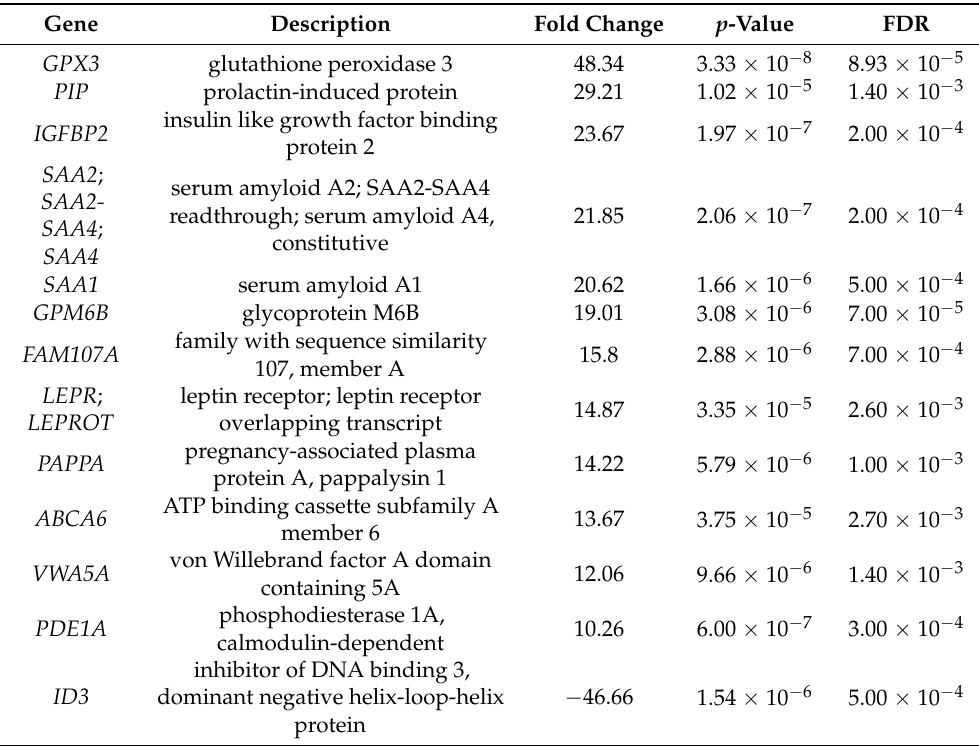
Table 1. Genes that were exclusively regulated in both cell types during induced osteogenic